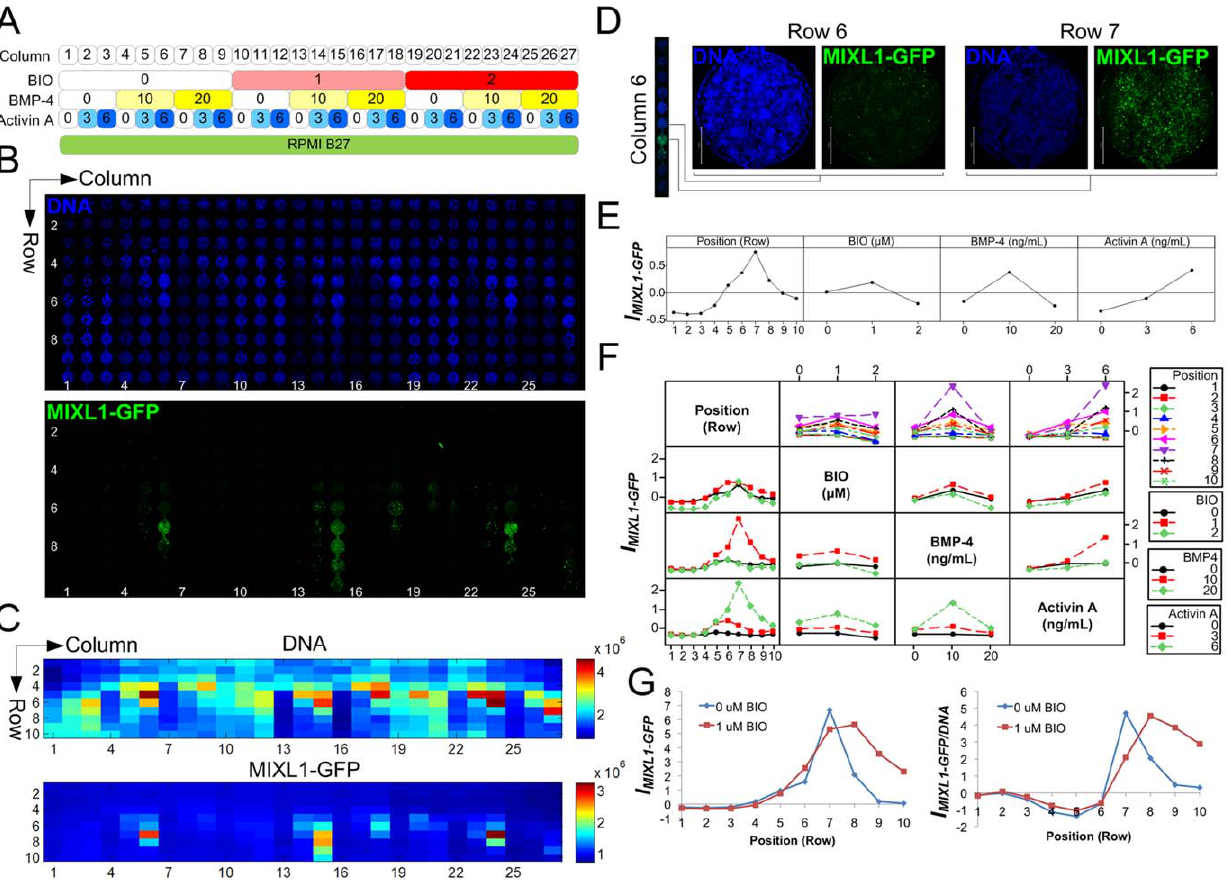
Figure 2. Microbioreactor screening of HES3( MIXL1 GFP/w ) cells undergoing mesendodermal differentiation demonstrates paracrine dependencies. A Screening panel showing array conditions in each column. Numbers indicate concentrations of BIO ( m M), BMP-4 (ng/mL)